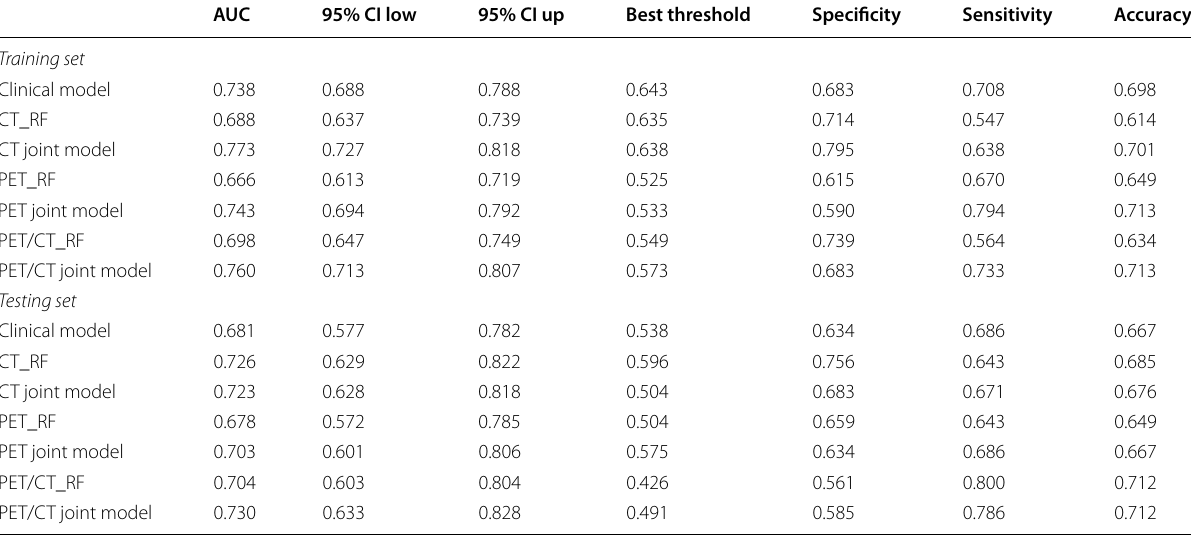
AUC area under the curve; CI confidence interval; RF random